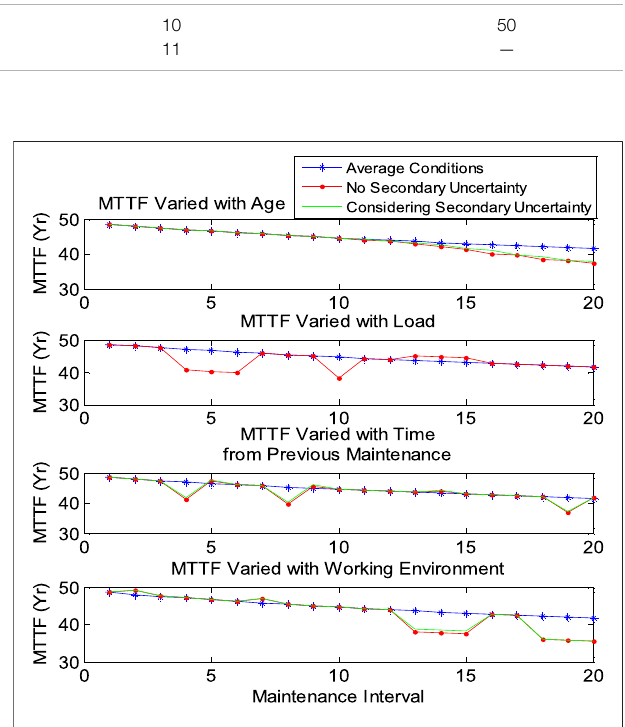
FIGURE 11 | Failure probability variation of the transformer with each individual operation condition. FIGURE 12 | MTTF variation of the transformer with each individual